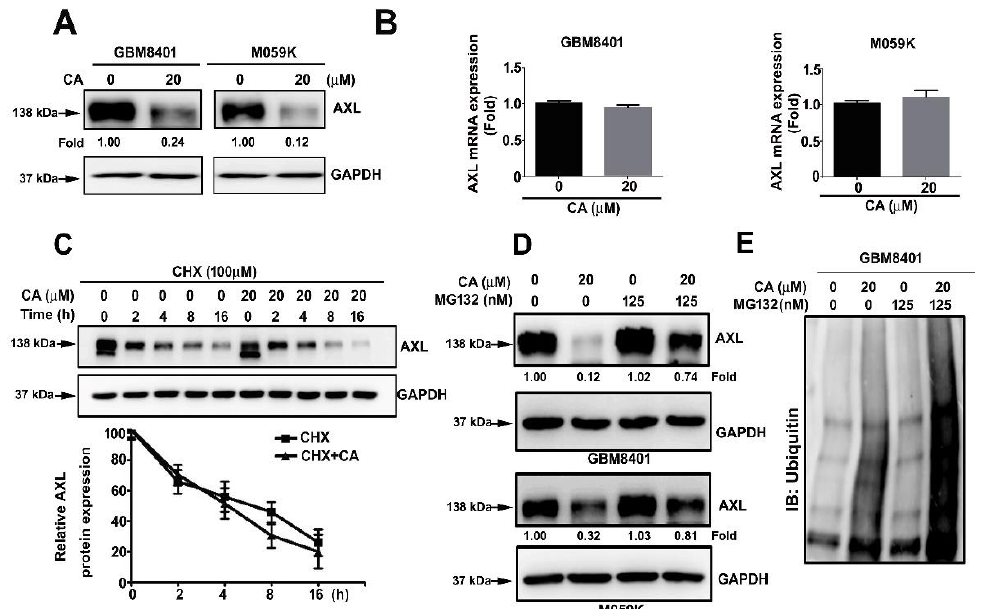
Figure 4. CA decreased AXL protein level by promoting ubiquitin-mediated proteasome degradation in GBM8401 cells ( A , B ) GBM8401 and M059K cells were treated with CA at 20 μ M for 24 or 6 h, and then lysed for AXL immunodetection by Western blotting ( A ) or for mRNA expression assessment of AXL by RT-qPCR ( B ). ( C ) GBM801 cells were treated with cycloheximide (CHX) alone or with CHX and CA for the indicated times and then lysed for AXL immunodetection by Western blotting. Chemiluminescence signal was semi-quantitated by densitometric analysis, and GAPDH was used as an internal control. ( D , E ) GBM8401 and M059K cells were treated with CA, MG132 or CA and MG132 for 24 h and lysed for AXL immunodetection ( D ) or ubiquitin ( E ) by Western blot- ting.